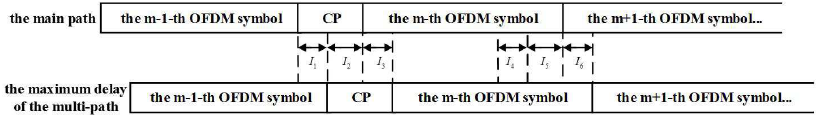
Figure 2. OFDM model signals over UAV